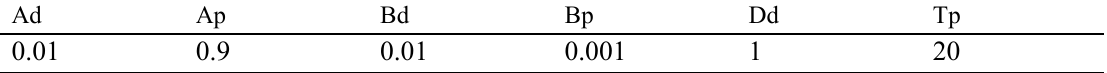
Table 1 Parameter values used for inversing transfer function of every basin of Saint-Brieuc’s Bay. Ad Ap Bd Bp Dd Tp 0.01